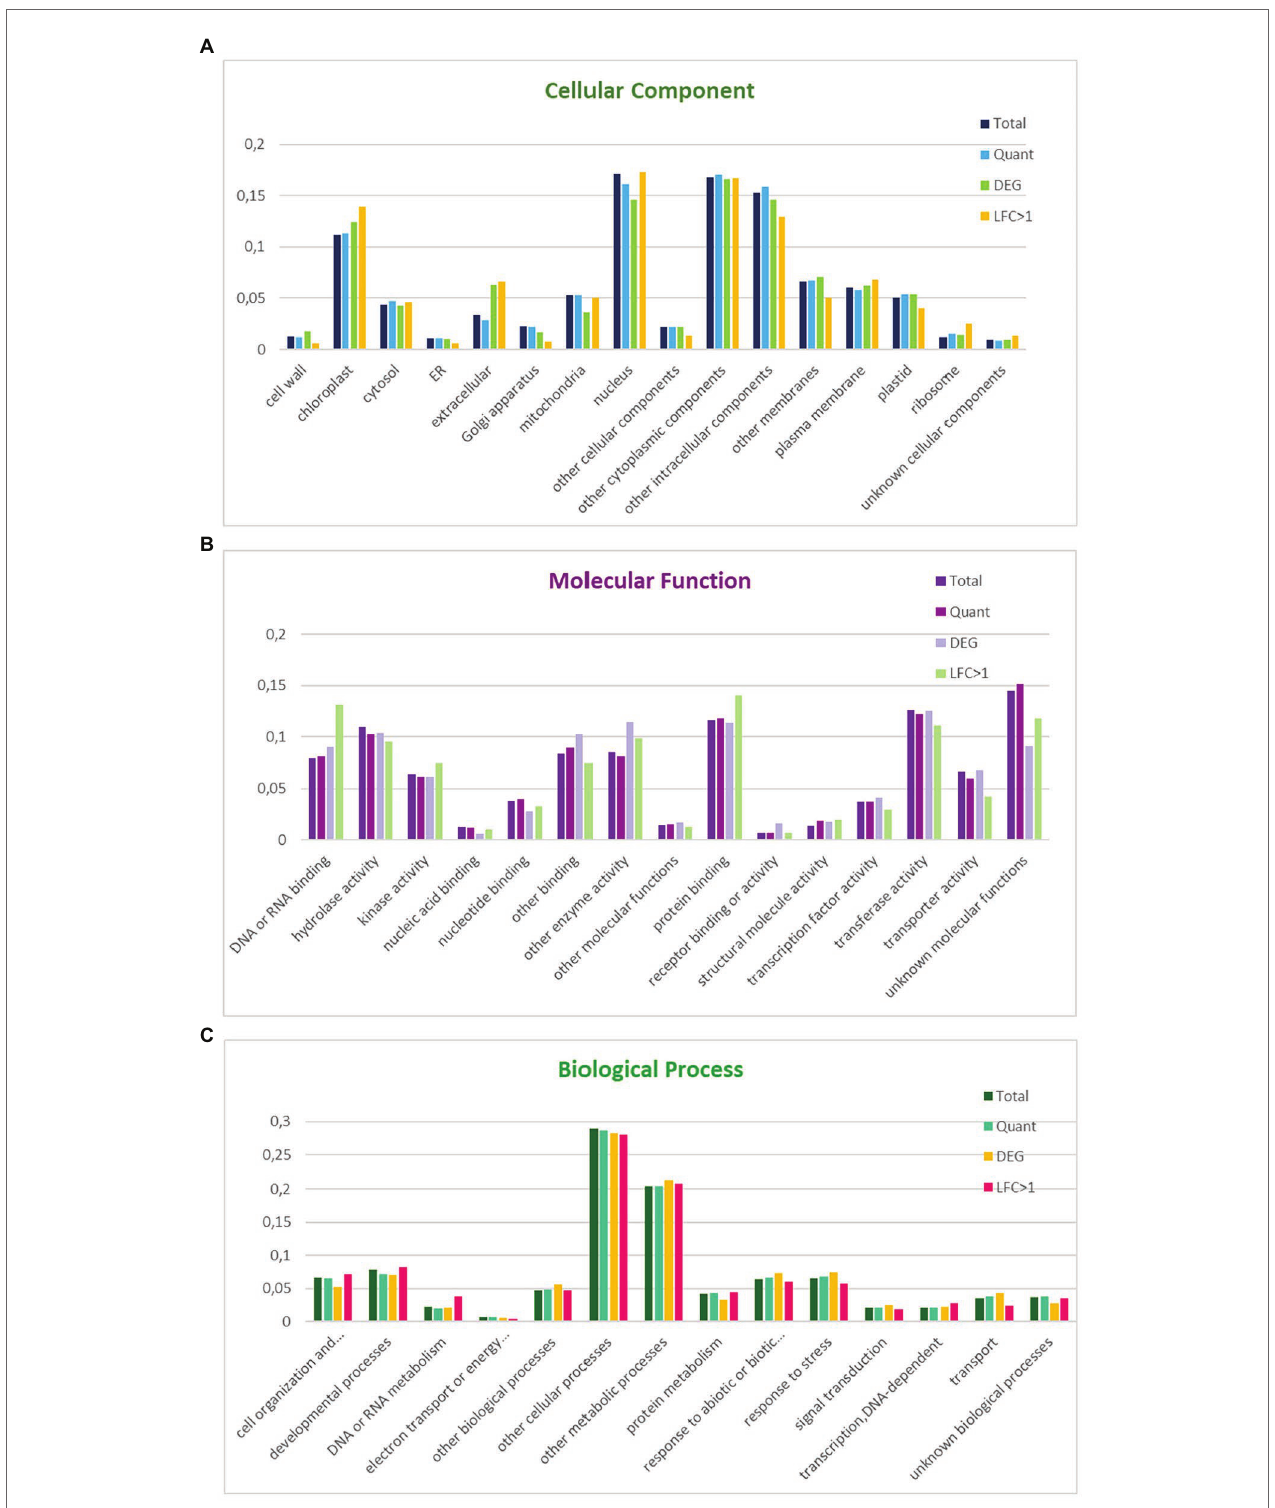
FIGURE 1 | Distribution of GO slim terms in the floral reference transcriptome, the set of informative transcripts used in the quantitative analysis, and the genes differentially expressed between floral morphs in Nigella damascena . Distributions are compared within GO cellular component (A) , molecular function (B) , and biological process (C) . Total: reference transcriptome; Quant: transcripts in quantitative analysis; DEG: genes differentially expressed between the two morphs; LFC > 1: most differentially expressed genes between the two